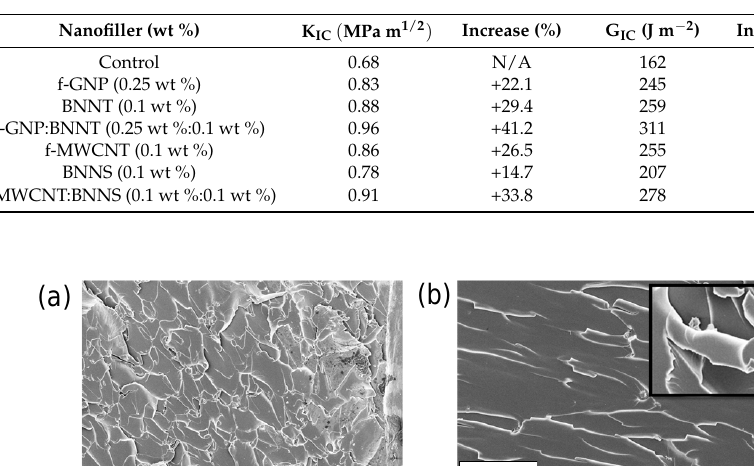
Table 5. Variation of K IC and G IC for the hybrid nanocomposites relative to the neat epoxy.